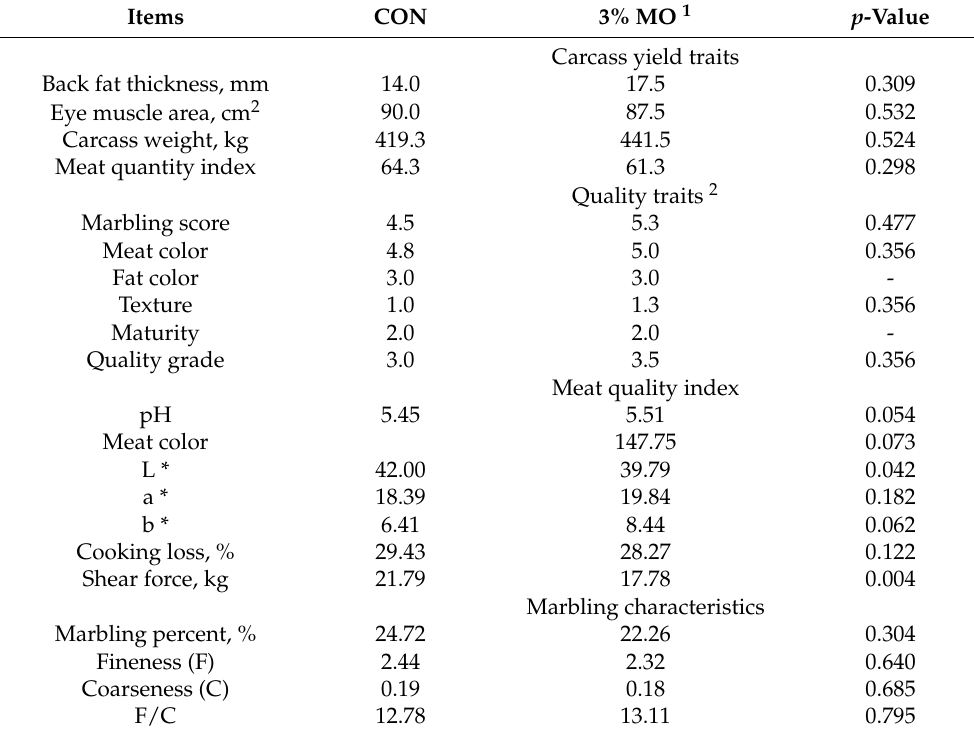
Table 6. Effect of 3% rumen-protected microencapsulated supplement (MO) on the carcass traits, meat quality, and marbling characteristics of